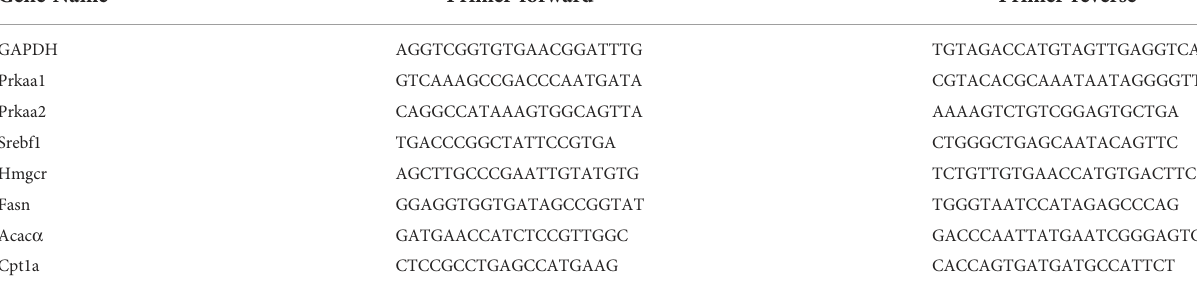
TABLE 1 The primer sequences of mouse liver